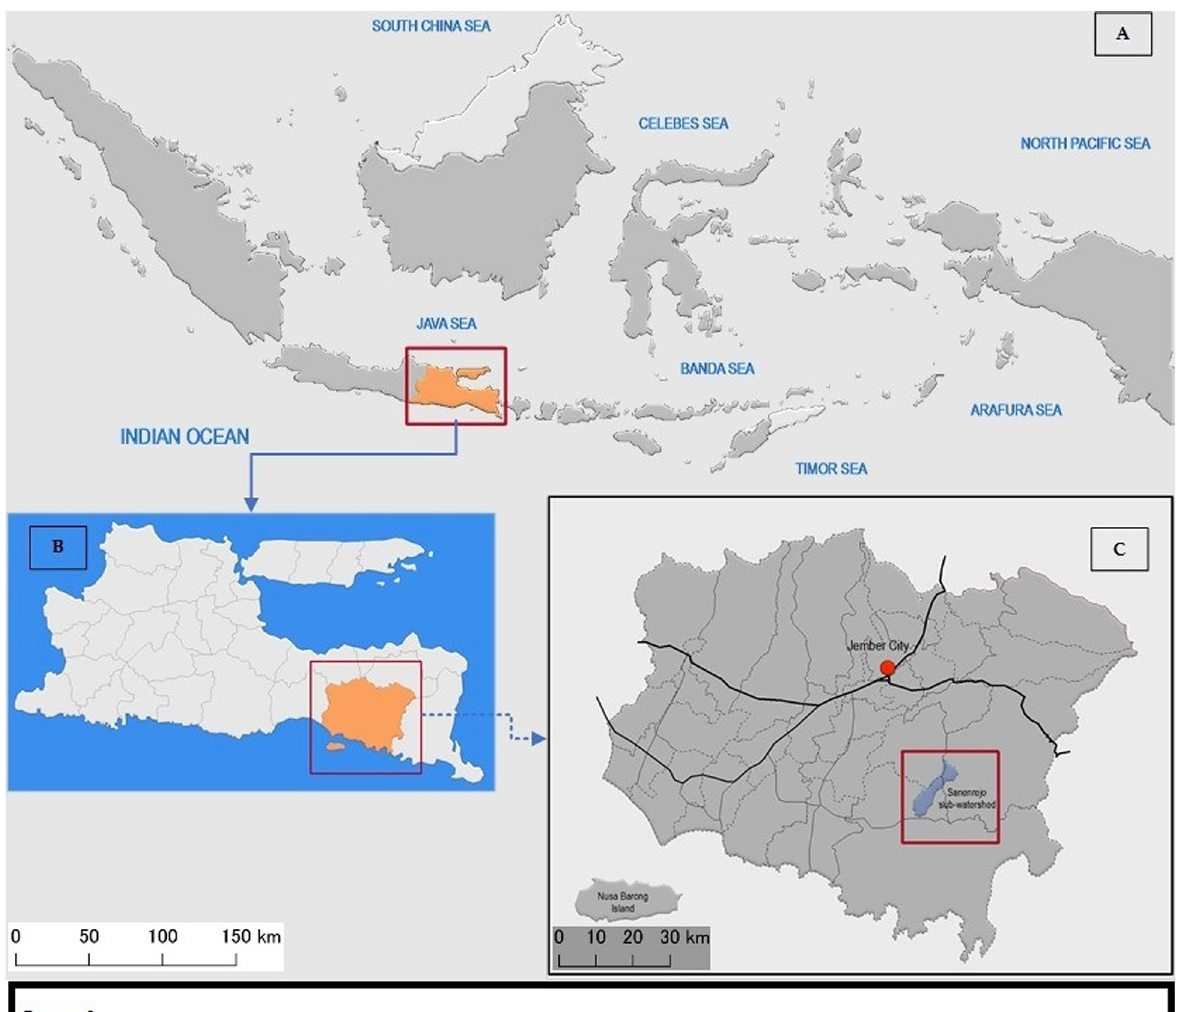
Fig. 1. Map of the study